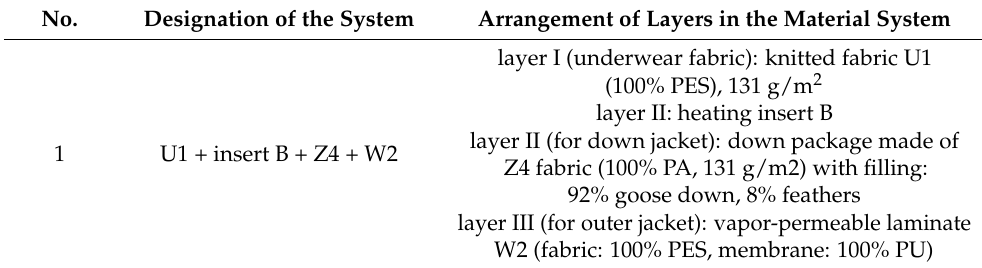
Table 5. Material systems with heating insert for temperature distribution testing.